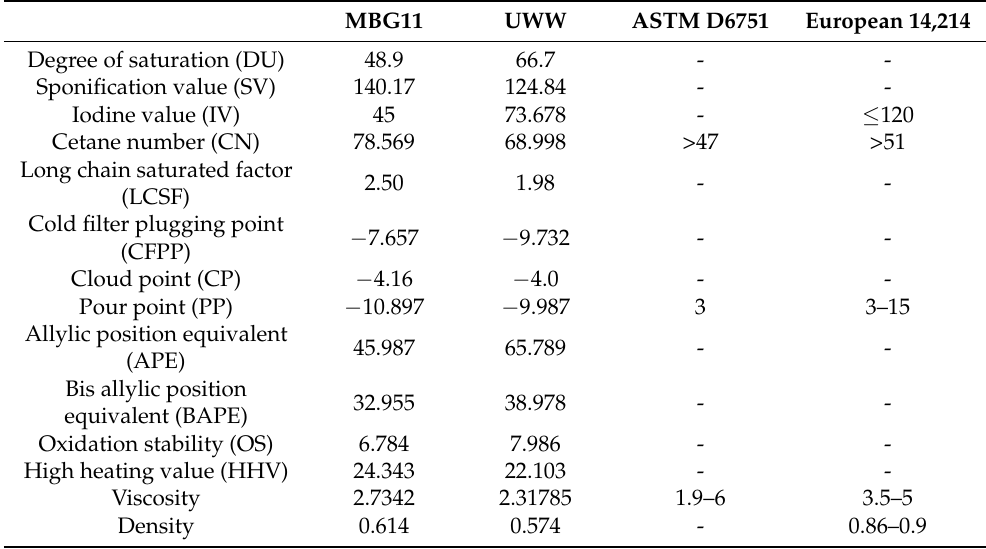
Table 2. Biodiesel properties of algal biomass grown in MBG11 and UWW and their comparison with